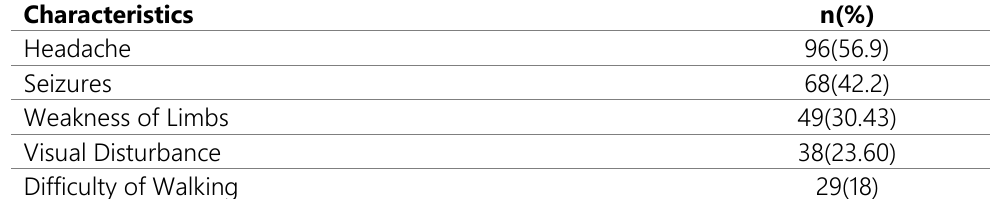
Table 1: Clinical presentation of the patient.